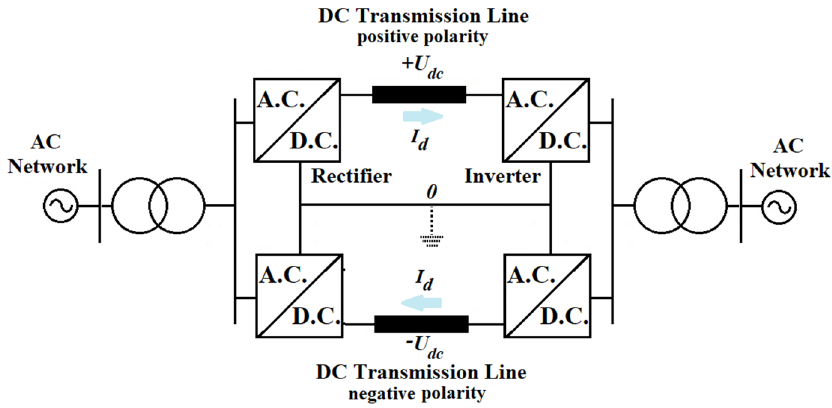
Figure 5. HVDC bipolar links metallic return conductor.